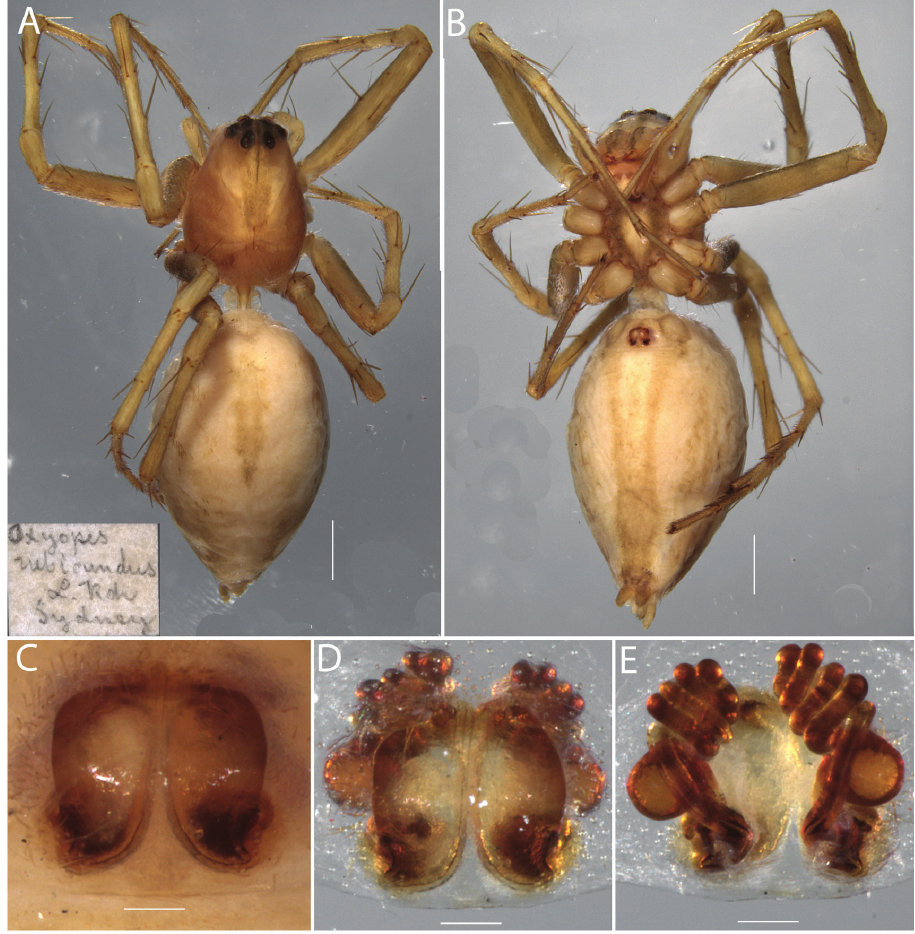
Figure 17. Oxyopes rubicundus L. Koch, 1878, female lectotype (ZMH- A0000019): A , habitus, dorsal view; B , habitus, ventral view; C , epigyne, ventral view; D, epigyne, ventral view, cleared; E , epigyne, dorsal view, cleared. Scale bars: habitus 1.0 mm, epigyne 0.1